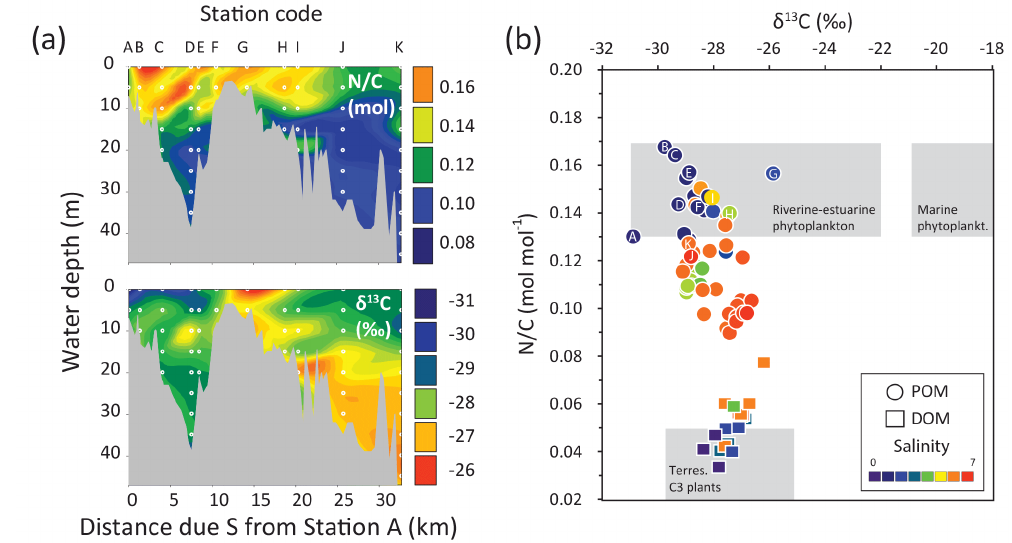
Figure 3. (a) 2-D contour plots of molar N / C (top) and δ 13 C (bottom) of particulate organic matter (POM) along the Mustionjoki tran- sect, operationally defined by filtration at 0.45µm, June 2015. White circles represent sampling positions (vertical depth resolution = 5m). (b) Cross plot of molar N / C vs. δ 13 C of POM in June 2015 (circles, each representing a single sample from the 2-D plot in a ) and of published data for dissolved organic matter (DOM) from the same transect (squares, surface water only, six samples each from campaigns in April, August and October 2011). In situ salinity at the time and location of sampling is indicated by the color scale. Samples marked with letters indicate surface water samples. Organic matter source fields are taken from Goñi et al. (2003).